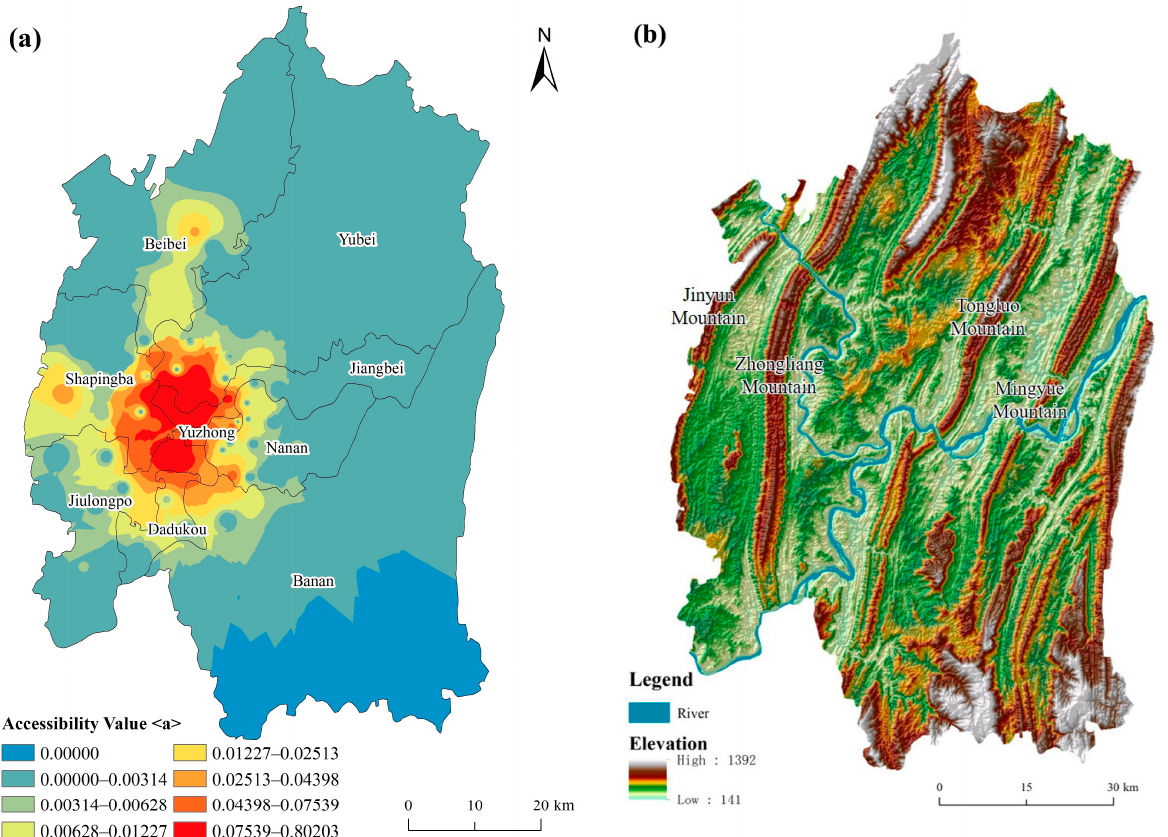
Figure 3. ( a ) The accessibility value of electric vehicle charging in the central urban area of Chongqing; ( b ) topographic map of the central urban area in Chongqing.